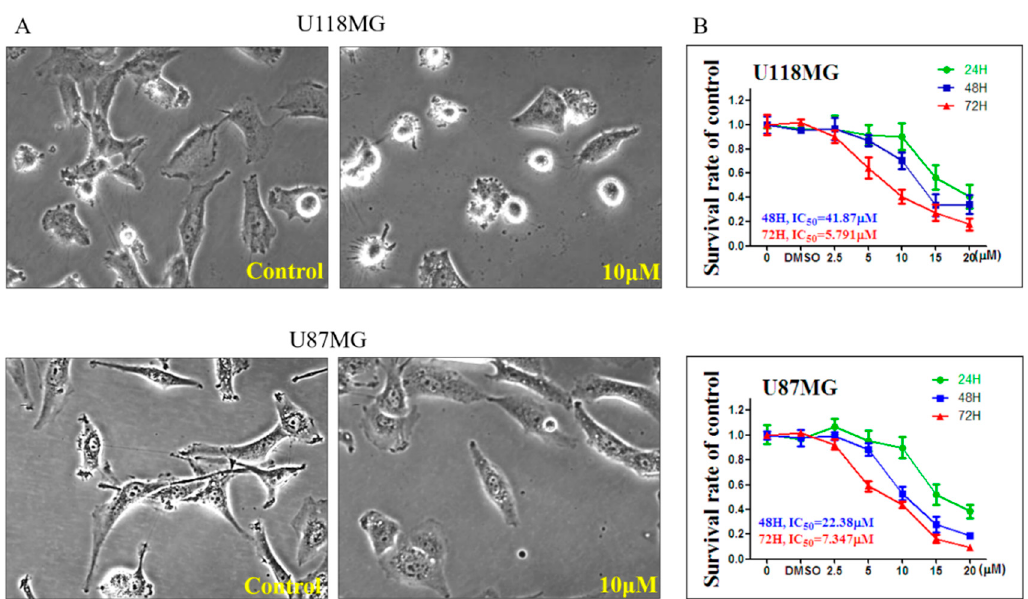
Figure 2. CC12 induced cell death and decreased the survival rate with time- and dose-dependent manners in glioblastoma (GBM) cell lines. ( A ) GBM cells showed shrinking and low cell density after CC12 treatment for 24 h. ( B ) (3-(4,5-Dimethylthiazol-2-yl)-2,5-diphenyltetrazolium bromide (MTT)assay results indicated the decease of the survival rate in both GBM cell lines.